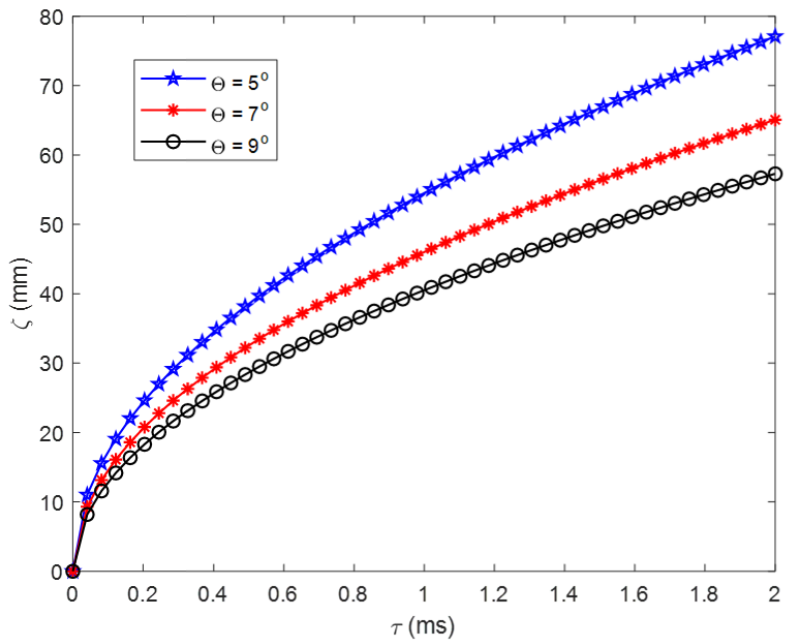
Figure 6. Effect of half liquid spray cone angle